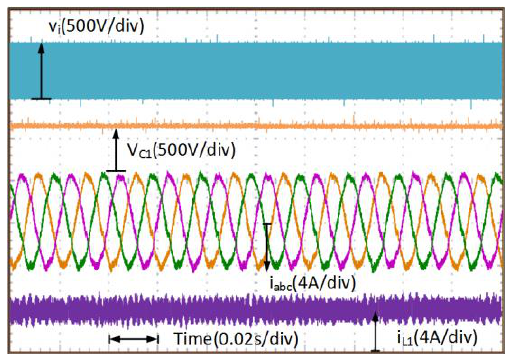
Figure 14. Experimental waveforms of the grid-side in half quasi-Z-source WPGS.